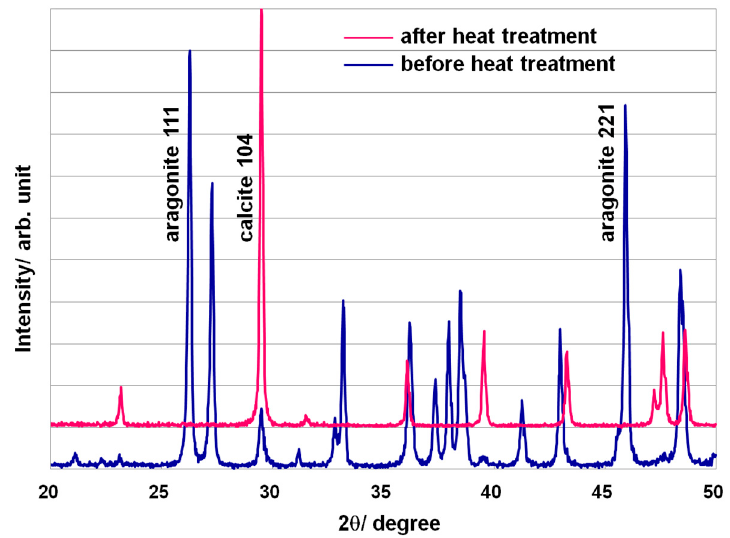
Figure 3. Powder XRD patterns of the calcium carbonate particles before (blue) and after (pink) the heat treatment.